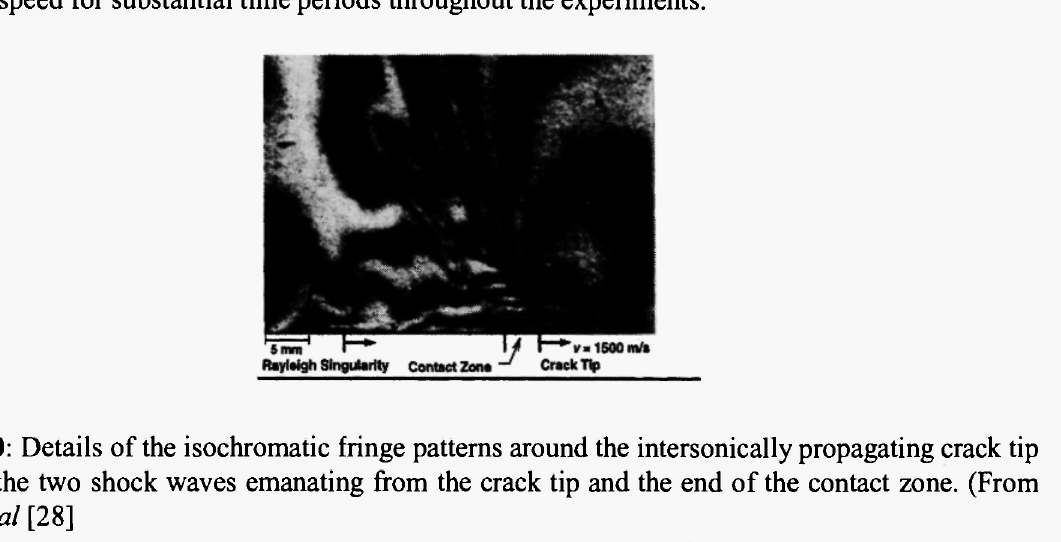
Figure 10: Details of the isochromatic fringe patterns around the intersonically propagating crack tip showing the two shock waves emanating from the crack tip and the end of the contact zone. (From Singh et. al